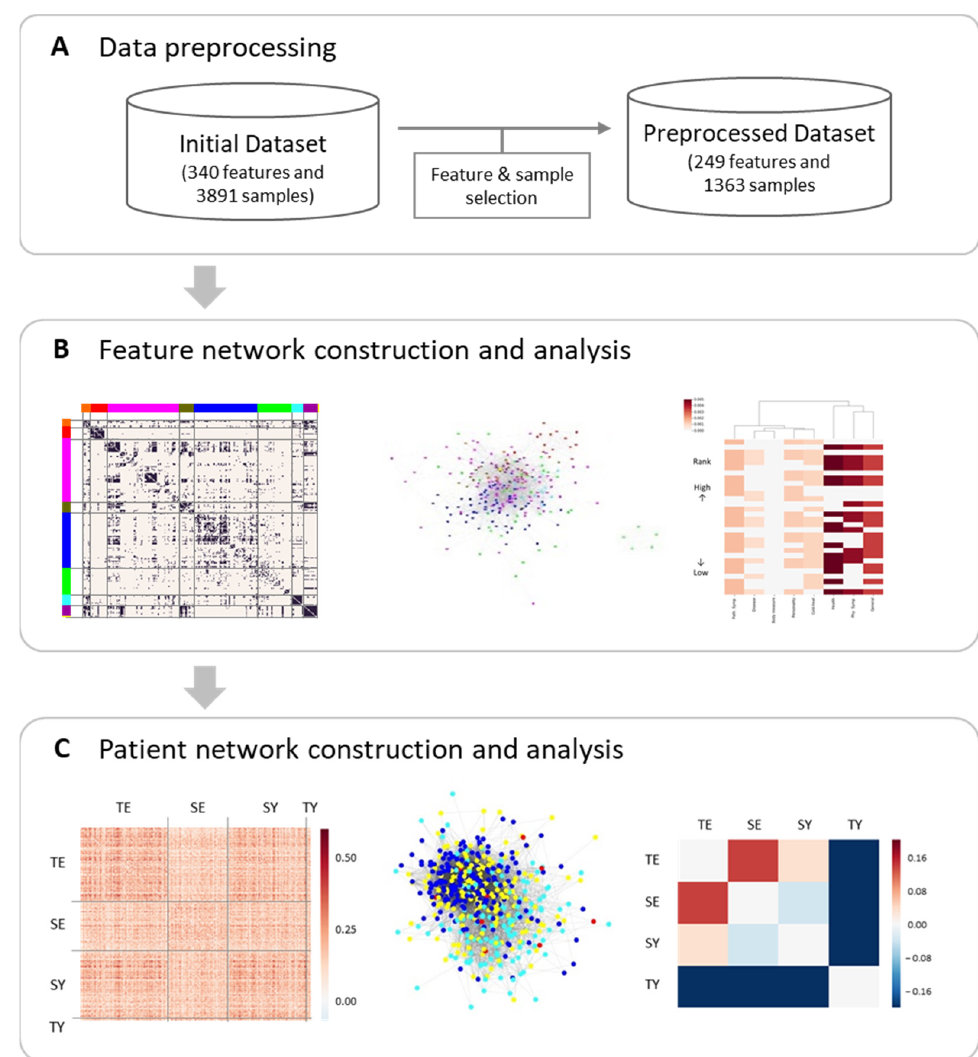
Figure 1. Overall research strategy of the network analytical approach: ( A ) data preprocessing was conducted by selecting features with high recording rates and associations to the SC type (see methods). The feature network ( B ) and patient network ( C ) were then constructed and analyzed, in which the nodes were defined as clinical features or the subjects, and the edges between nodes were computed using adjusted MIs between features or